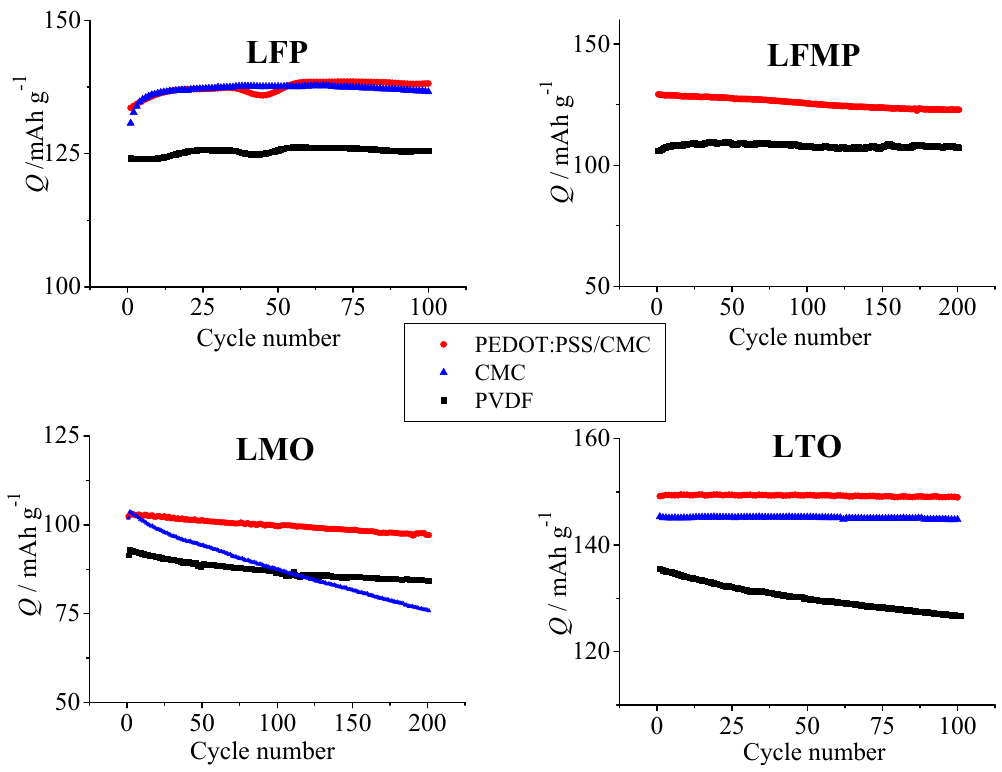
Figure 8. Cycling performance at 1 C charge and discharge for electrodes with PEDOT:PSS/CMC, CMC, and PVDF binders (based on our data in Ref. [64–67]). Energies 2020 , 13 , x FOR PEER REVIEW